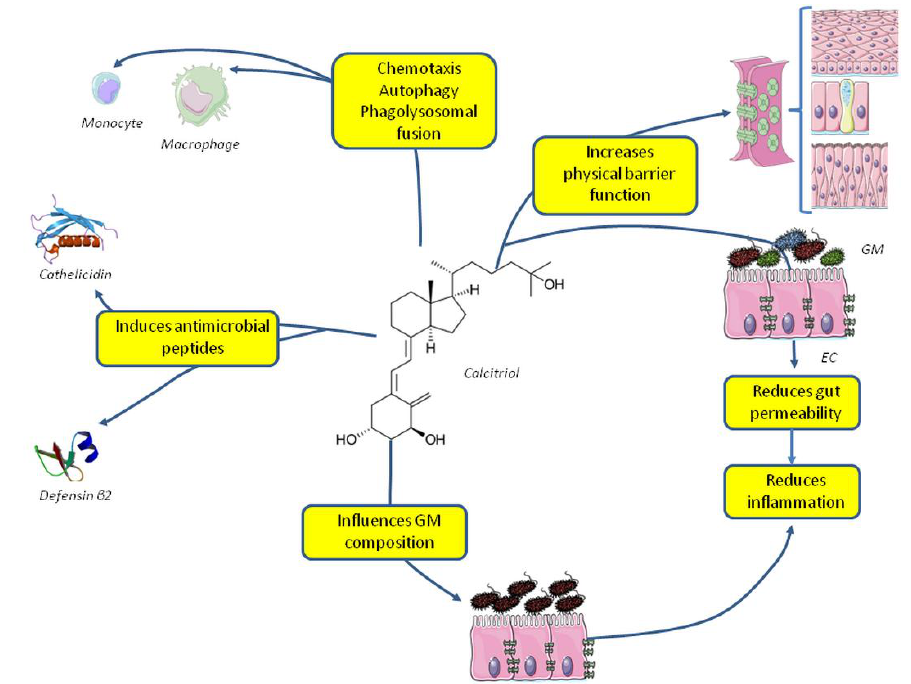
Figure 1. Effects of vitamin D on the innate immune system and gut microbiota. Abbreviations: EC, enteral cells; GM, gut microbiota.